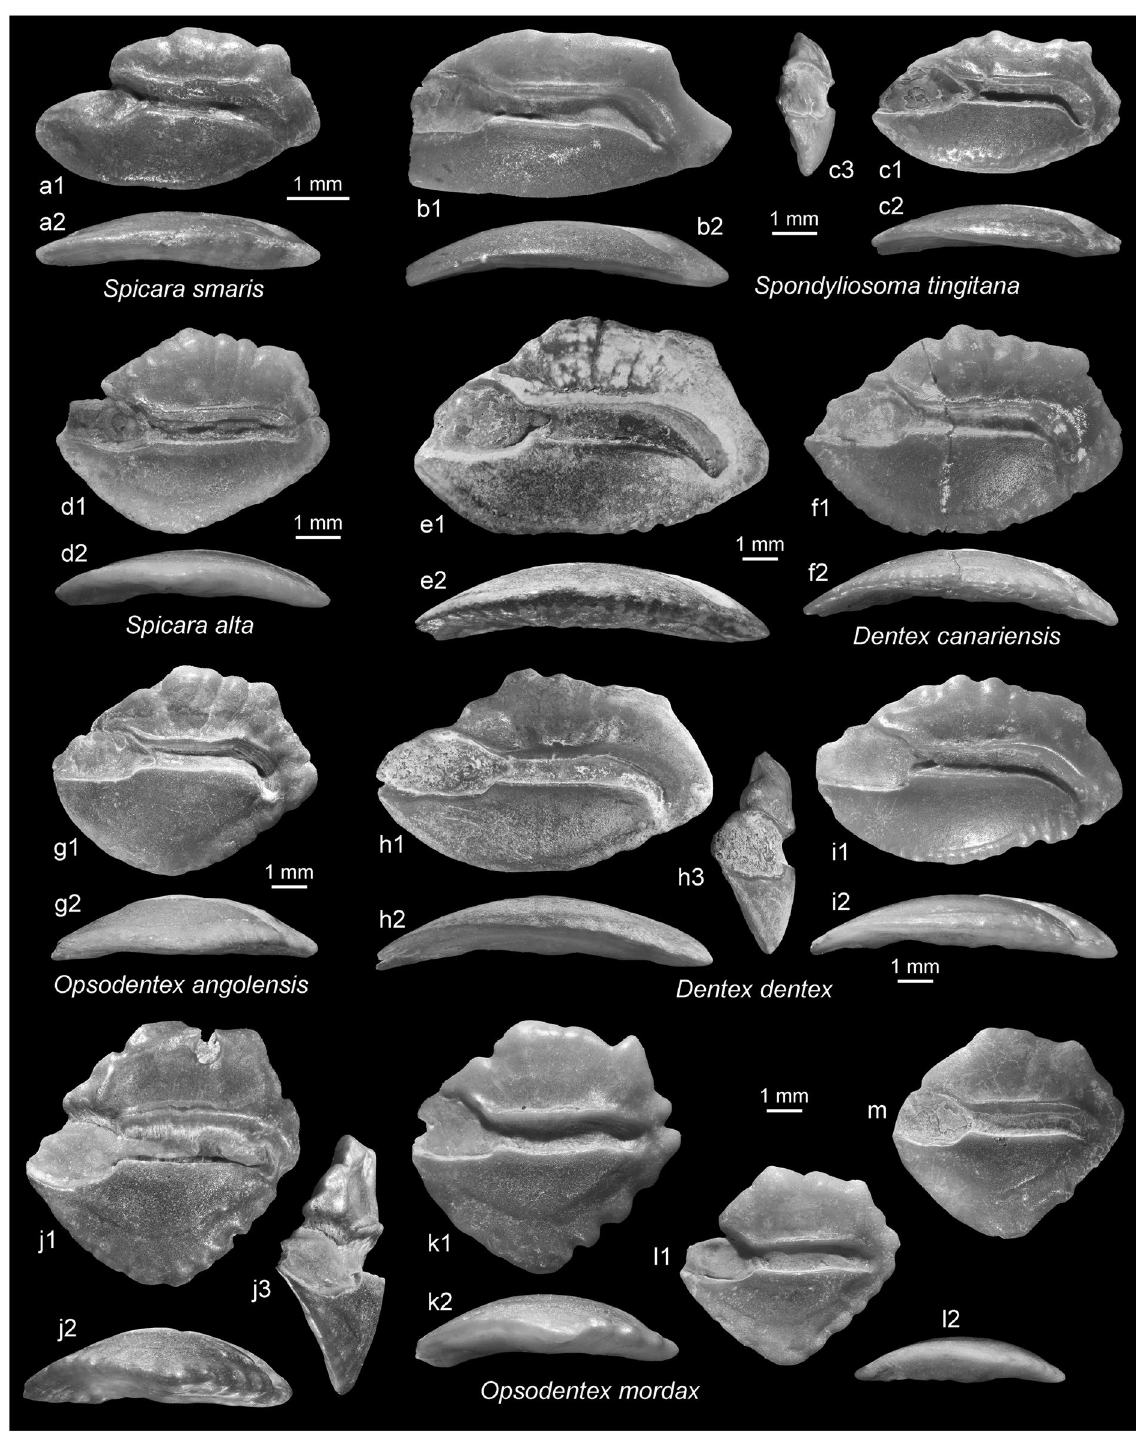
Fig. 27 Sparidae. a Spicara smaris (Linnaeus, 1758), SMF PO 101.292, Dar bel Hamri. b – c Spondyliosoma tingitana n. sp., Dar bel Hamri, Zanclean, c holotype, SMF PO 101.293 (reversed), b paratype, SMF PO 101.294 (reversed). d , Spicara alta (Osório, 1917), SMF PO 101.291, Dar bel Hamri. e – f Dentex canariensis Steindachner, 1881, SMF PO 101.266 ( f reversed), Dar bel Hamri. g Opsodentex angolensis Poll & Maul, 1953, SMF PO 101.268. h – i Dentex dentex (Linnaeus, 1758), SMF PO 101.267 ( h reversed). j – m Opsodentex mordax n. sp., Dar bel Hamri, Zanclean, j holotype, SMF PO 101.269 (reversed), k – m paratypes, SMF PO 101.295 ( k – l